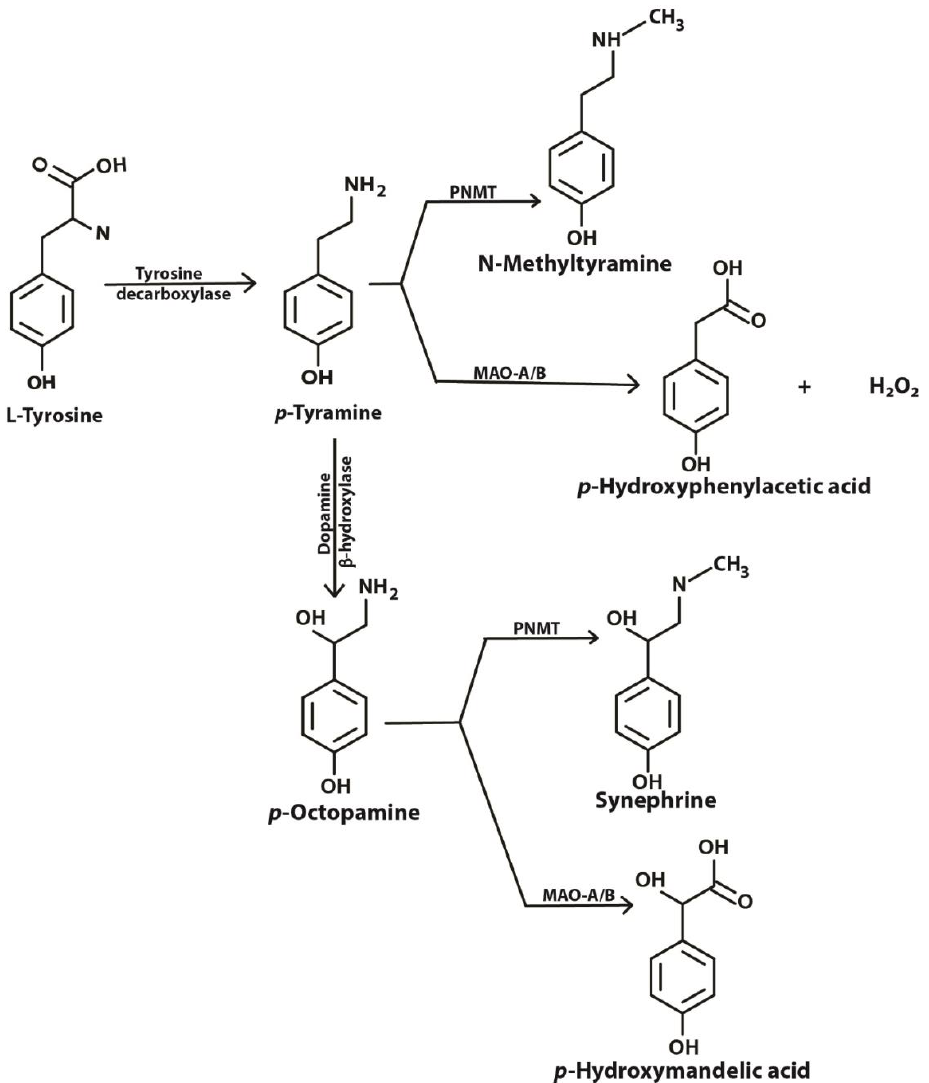
Figure 1. Metabolic pathway showing biosynthesis and fate of tyramine inside a cell. PNMT, phenylethanolamine-N-methyl transferase; MAO-A/B, monoamine oxidase A or B (adapted from [1] under license agreement CC BY-NC 4.0).